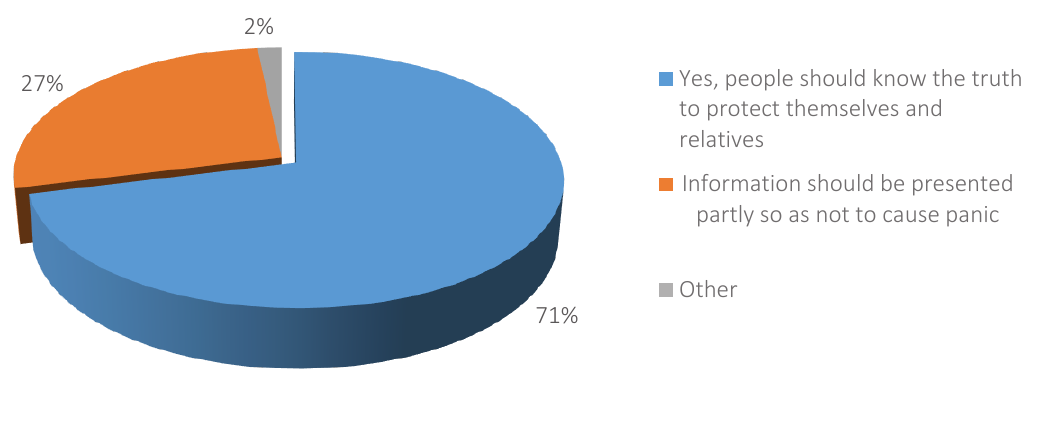
Figure 6. Respondents’ assessment of the need to provide the media with complete information about the